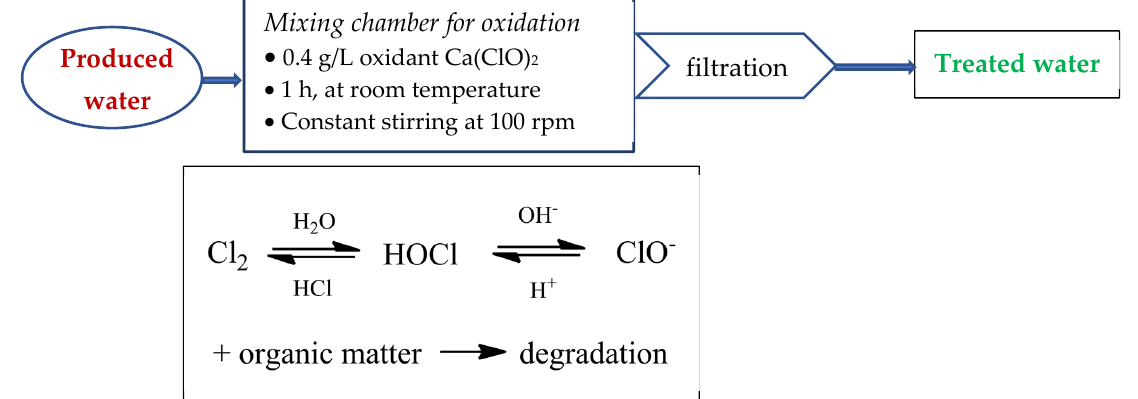
Scheme 2. Diagram for chemical oxidation of produced water.